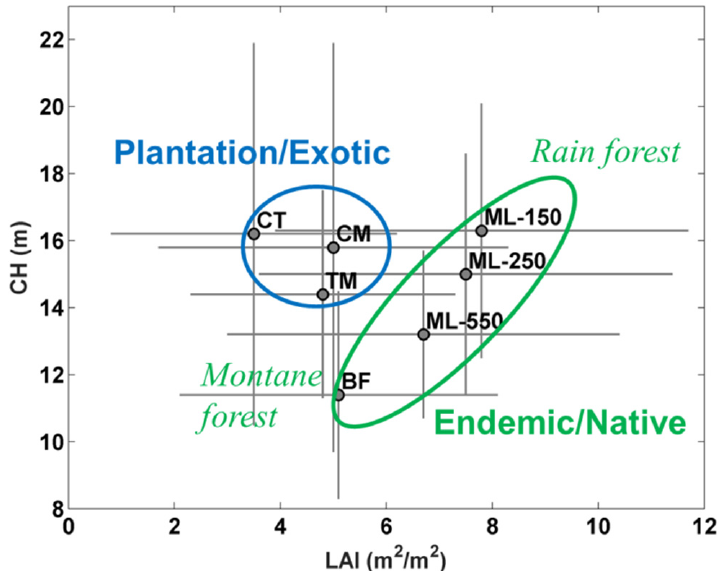
Figure 11. Mean (dot) and standard deviations (line segments) of forest LiDAR-derived LAI against the canopy height (CH) for the seven sites: coastal (CT), Tamarind (TM), Cryptomeria (CM), Bélouve (BF) and Mare-Longue (ML-150, -250 and -550) sites. Measurements with CH < 5 m are not considered.